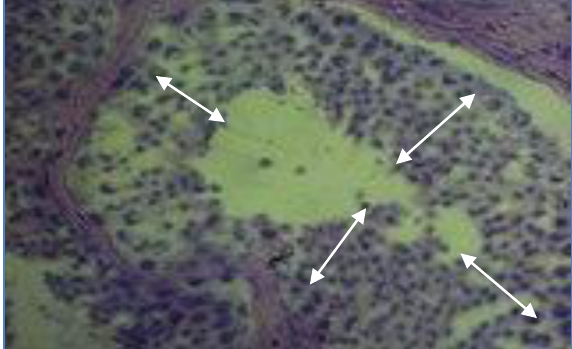
Figure, 1: Spermatgenic cells (double arrows) inside seminiferous tubules during spring season. PAS X400.